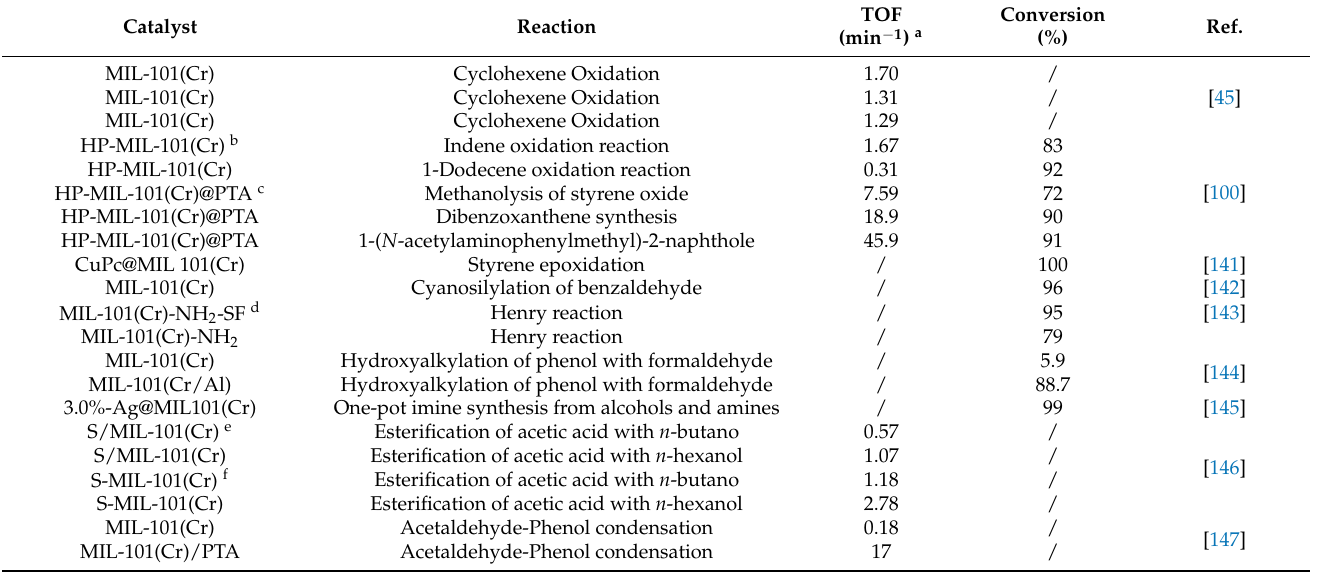
Table 5. Application of different MIL-101 and MIL-101(Cr)-based materials in catalytic reactions. Catalyst Reaction